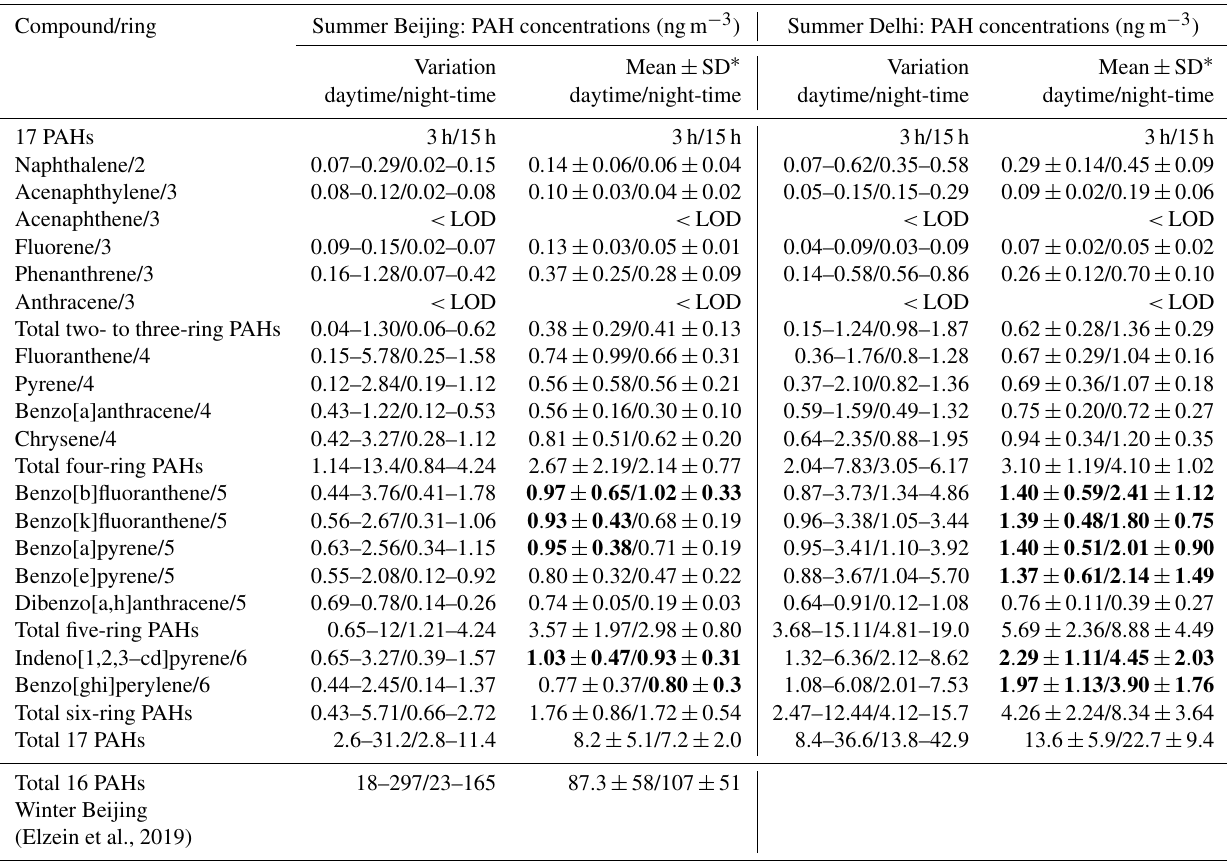
Table 1. Minimum, maximum and mean concentrations of individual PAHs in PM 2 . 5 . Compounds in bold represent the highest mean contribution to the sum of all